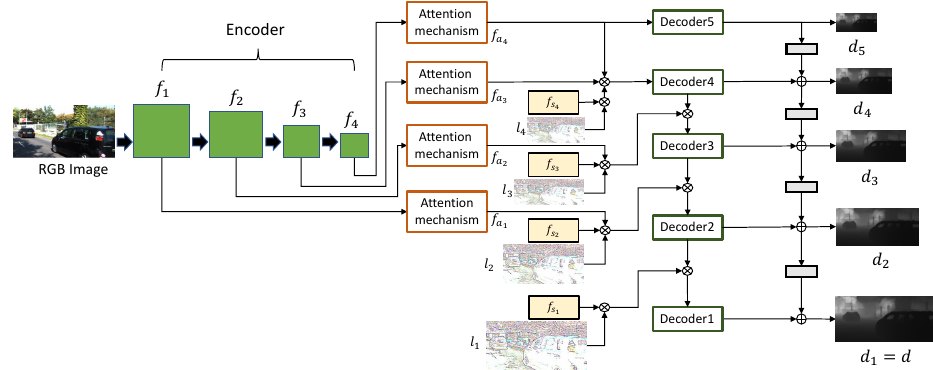
Figure 3. The foreground depth prediction model